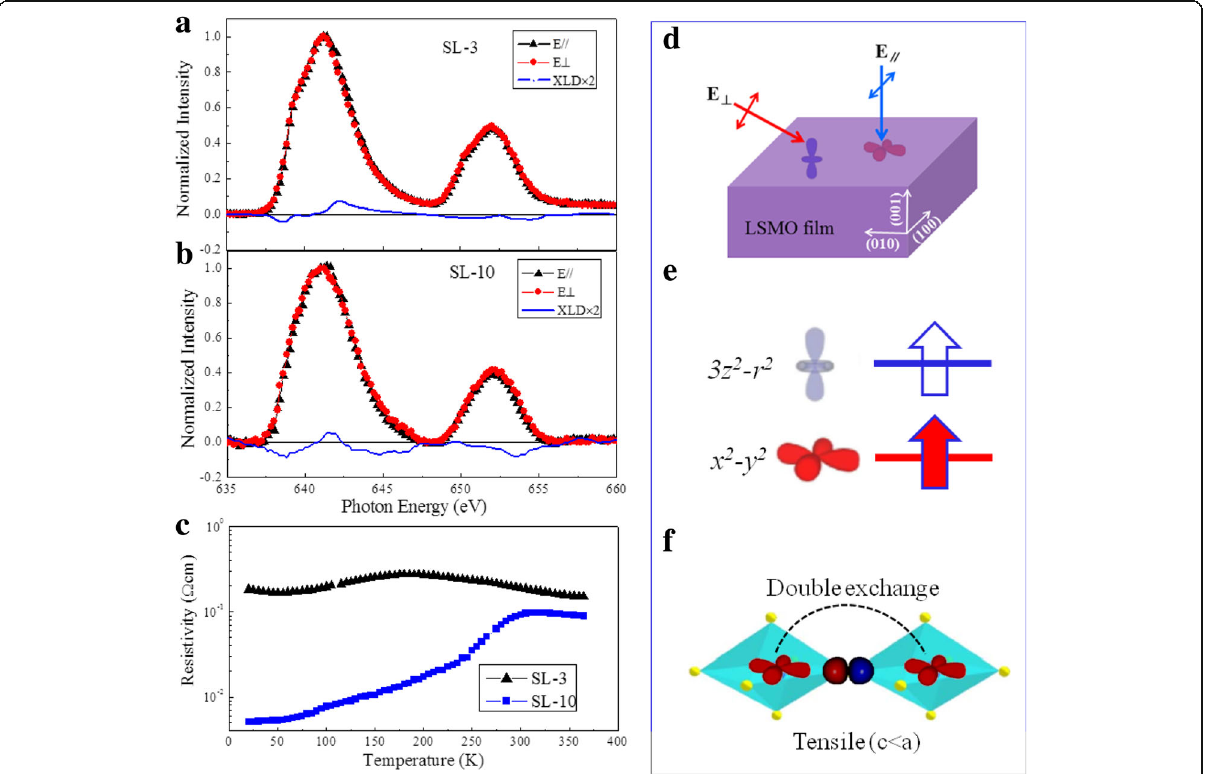
Fig. 4 a, b Normalized XAS and XLD curves for samples SL-3 and SL-10 measured at room temperature. c Temperature-dependent resistivity measured in the temperature range from 20 to 365 K for (001)-oriented SL-n samples where n = 3 and 10. d Experimental configuration schematic diagram for XAS measurements with different X-ray incident angles. e Schematic representation of the electronic orbital occupancy of manganese e g in (001)-oriented LSMO/BTO superlattices. f Proposed double exchange coupling mechanism along the in-plane